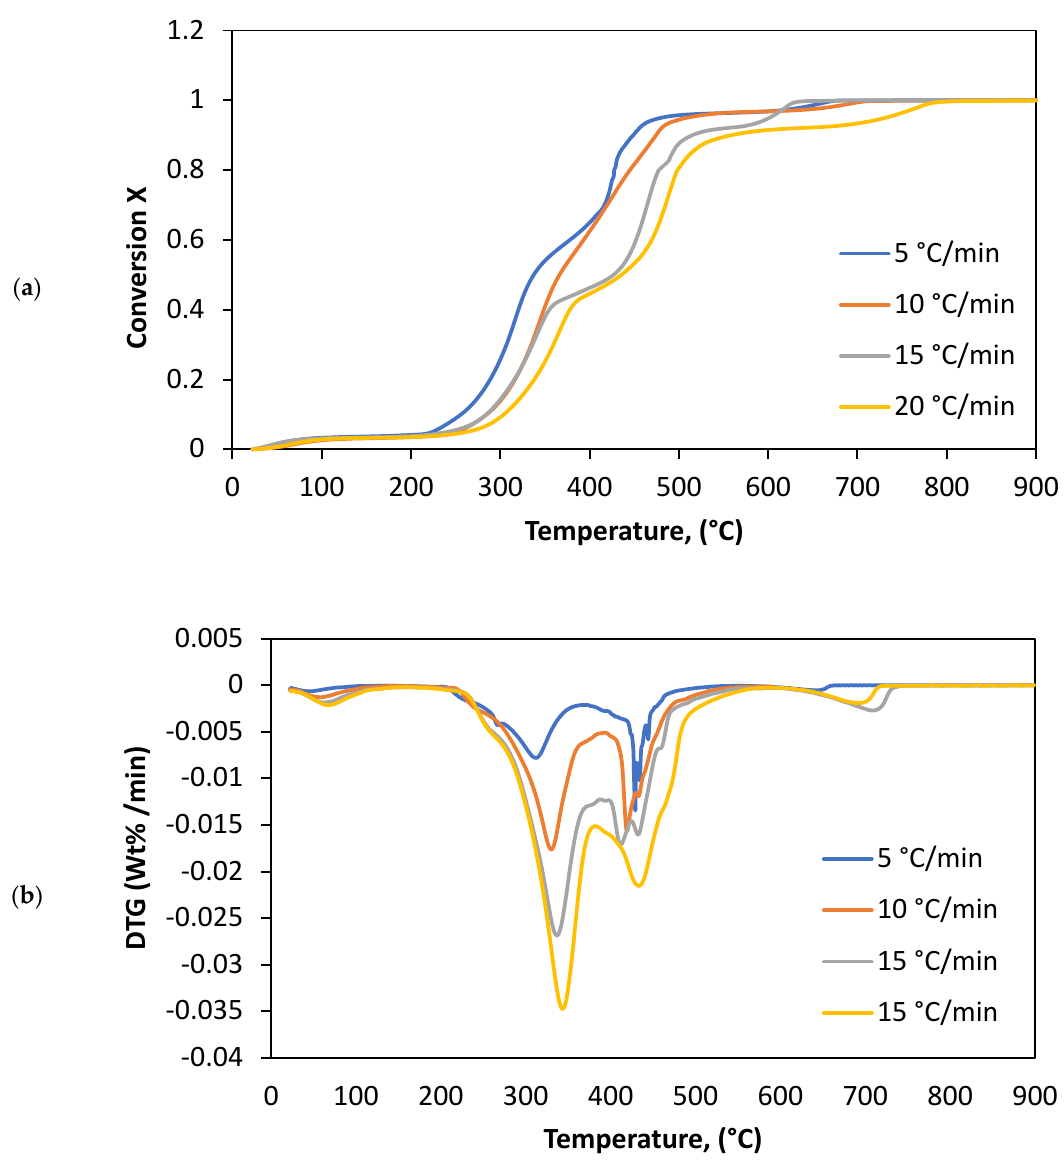
Figure 3. The effect of the heating rate in air: ( a ) conversion degree and ( b ) DTG weight loss. As the heating rates increases, the T m within the sample rises, which leads to faster Table 3. Thermal decomposition of Subcoal™ PAF in CO 2 from TGA curves. chemical reaction kinetics and Subcoal™ PAF conversion to gaseous products [20]. More- over, the lower the heating rate, the longer the reaction residence time, and, hence, the lower amount of Subcoal™ PAF converts. The conversion curve represents fourth stages of sample decomposition. In the first stage, for temperature less than 150 ◦ C, it is during the dehydration process that the volatile material and moisture leave the sample with insignificant changes in the mass. Then, in the second and third stages, a region between 250 ◦ C to 550 ◦ C, which is known as active conversion, the sample losses most of its mass in the devolatilization process. In the final stage, only ash and char are left, which is less than 15% of the sample mass [21]. The weight slowly reduces in the first and the last stage, which is known as the passive reaction. According to the DTG curves for Subcoal™ PAF under N 2 , CO 2 , and air at various